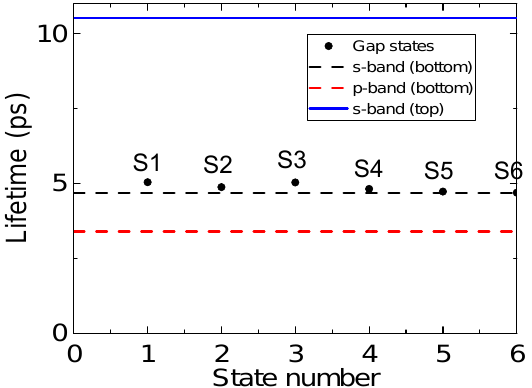
Figure 8: Calculated lifetime of the gap (solid dots) and bulk states